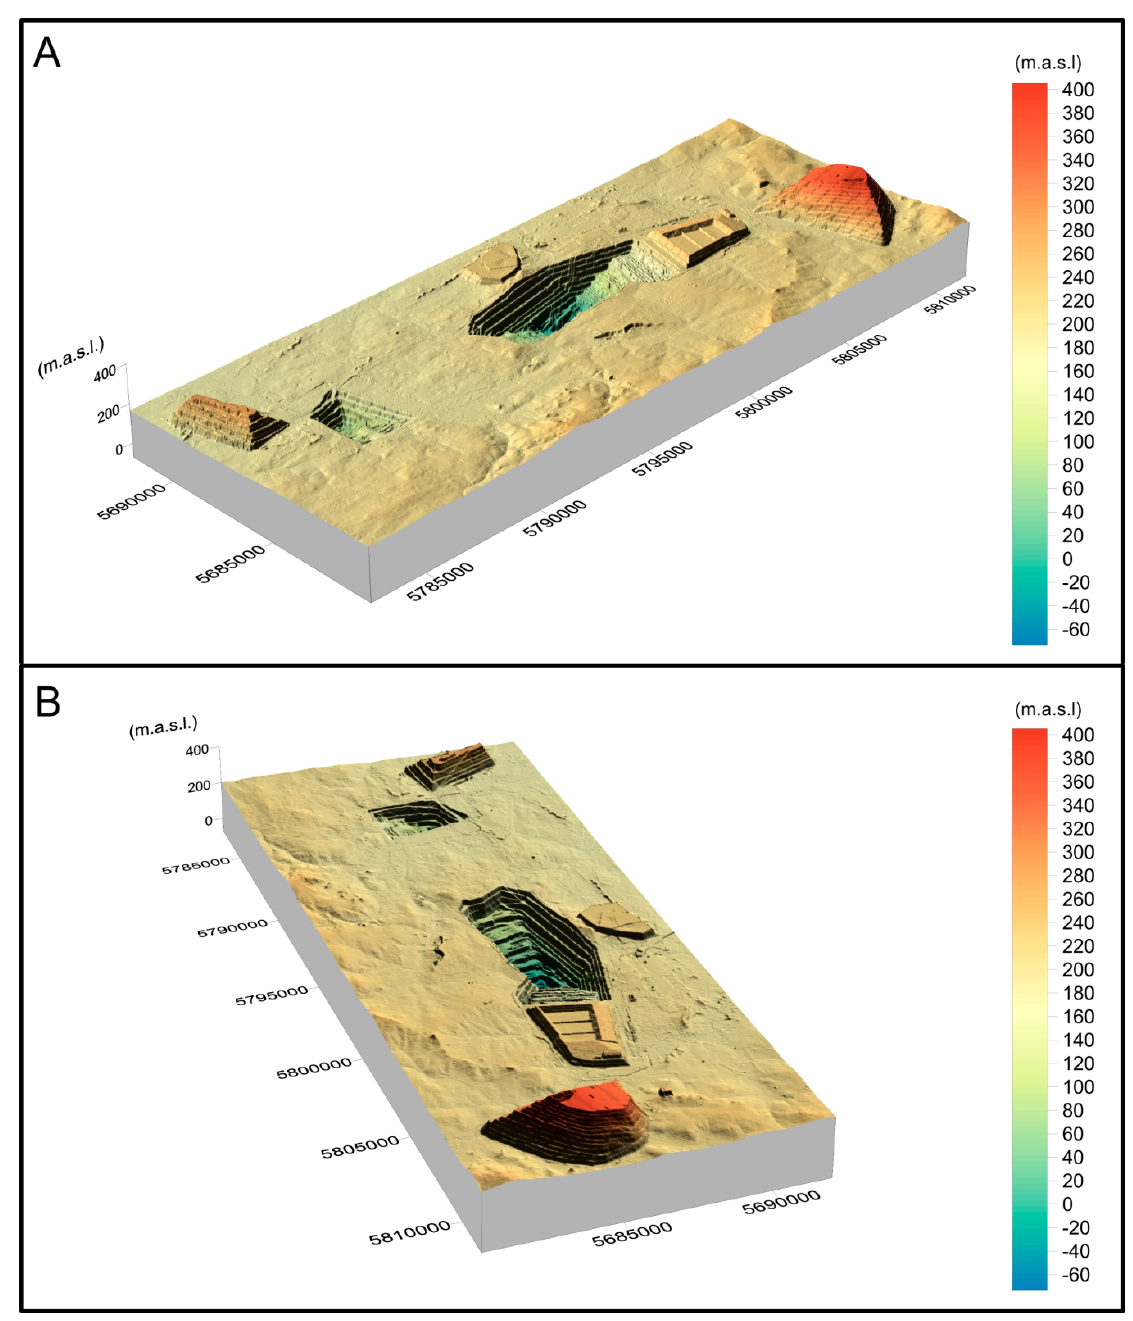
Figure 5. Digital Elevation Model of the analyzed area from the post-investment period. Three-dimensional view using a standard color ramp with shading, z-factor value of 7—SW view ( A )and SE view ( B ). Source: Own elaboration.